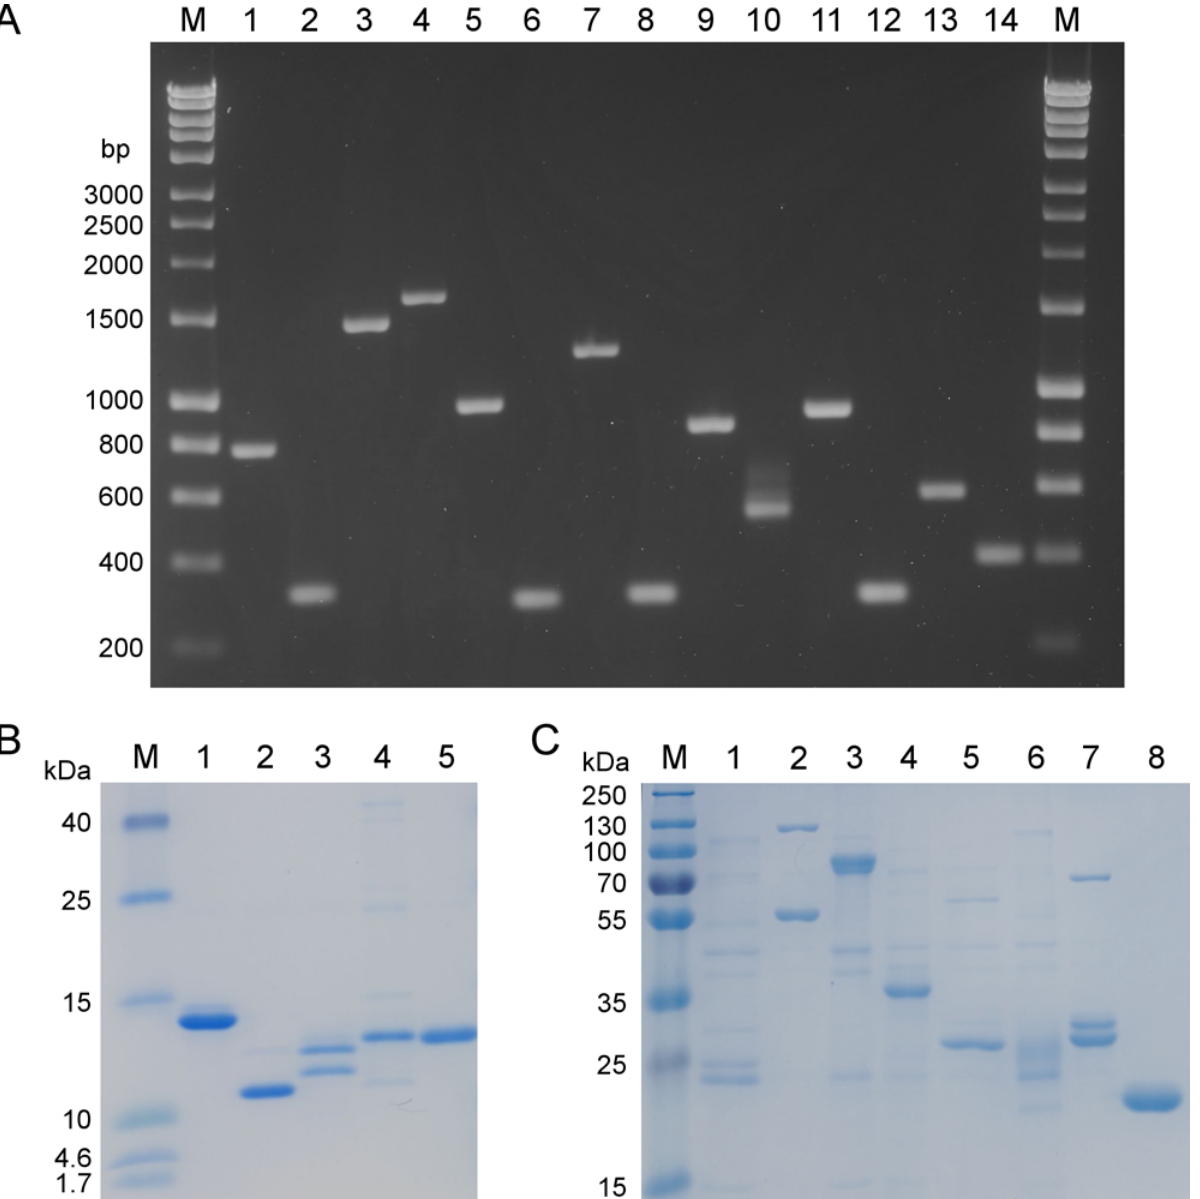
Fig 2. Cloning and protein expression of full-length genes and full-length proteins. A 1.5% agarose gel: M Hyperladder I (bioline, Bio-33025-26), 1 NGO0170, 2 NGO0326, 3 NGO0451, 4 NGO0564 (+ control), 5 NGO0642, 6 NGO0777, 7 NGO0916, 8 NGO1043, 9 NGO1500 (- control), 10 NGO1634,